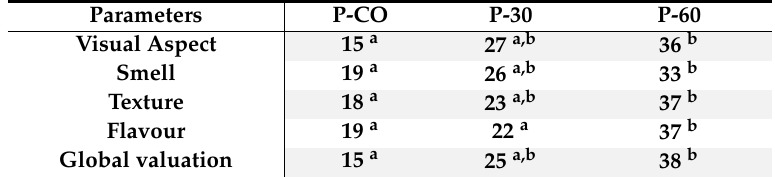
Figure 4. Preference score for each of the parameters showed in percentage; (P-CO: control sample; P-30 and P-60: samples with 30% and 60% of pork fat replacement, respectively). Table 4. Friedman test results using a valuation of 1, 2 or 3 for the preferred sample, second preferred sample and the third preferred sample, respectively. F(test) > F( α =